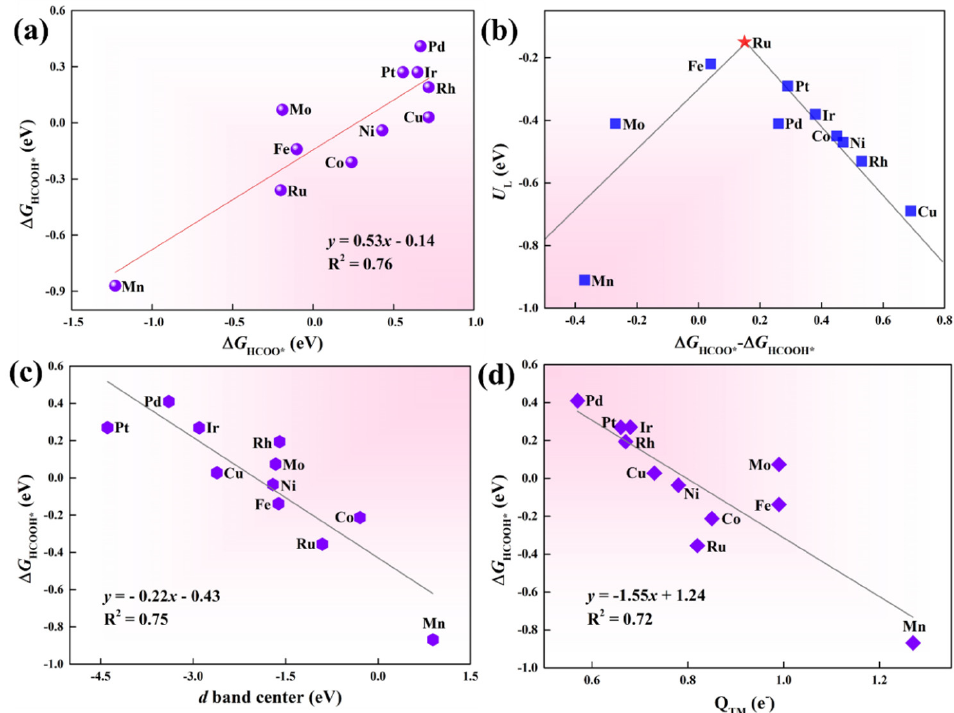
Figure 5. ( a ) ∆ G HCOOH* versus the ∆ G HCOO* species; ( b ) U L versus the free energy change of HCOO* and HCOOH* in each elementary step. The linear relationship between the adsorption free energy of HCOOH* and the corresponding ( c ) d band center and ( d ) Q TM